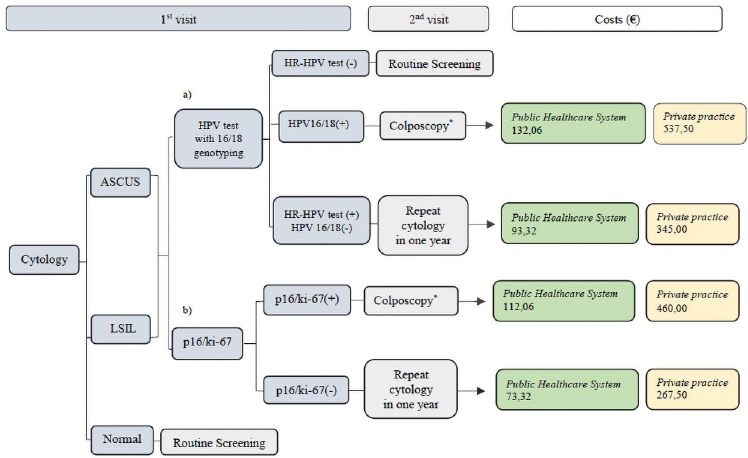
Fig 2. First strategy: Cytology as primary screening test. Triage with a) HPV test with 16/18 genotyping and b) p16/ ki-67 dual stain. Cytology, LBC; Costs in Euros ( € ), direct medical costs (screening tests, colposcopy with biopsy